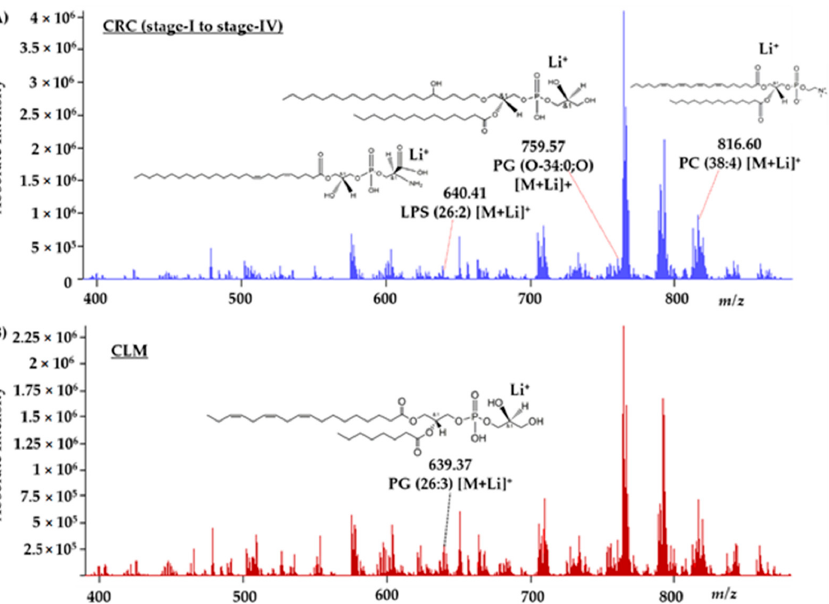
Figure 4. DIOS-HR-MS identified putative lithiated lipid subsets in plasma EVs. ( A ) When evaluating CRC group, the ions observed at m / z 640.41, m / z 759.57 and m / z 816.60 were matched with LPS (26:2) [M + Li] + , PG (O-340;O) [M + Li] + and PC (38:4) [M + Li] + , annotated in LipidMaps. These lipids were increased in intensity in the CRC group compared to CFI. ( B ) The peak observed at m /